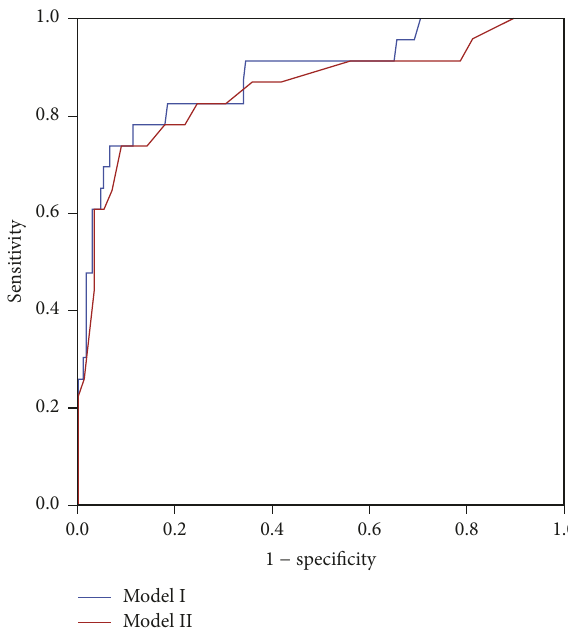
Figure 2: ROC curves of APACHE II and SAPS II scores predicting the 28-day survival